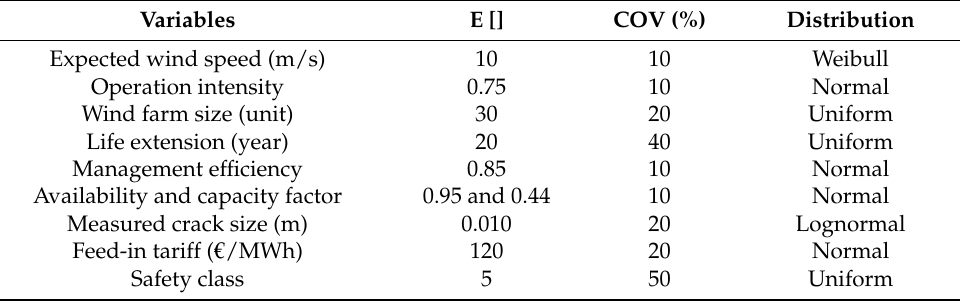
Table 2. Characteristic of variables involved in the intrinsic value